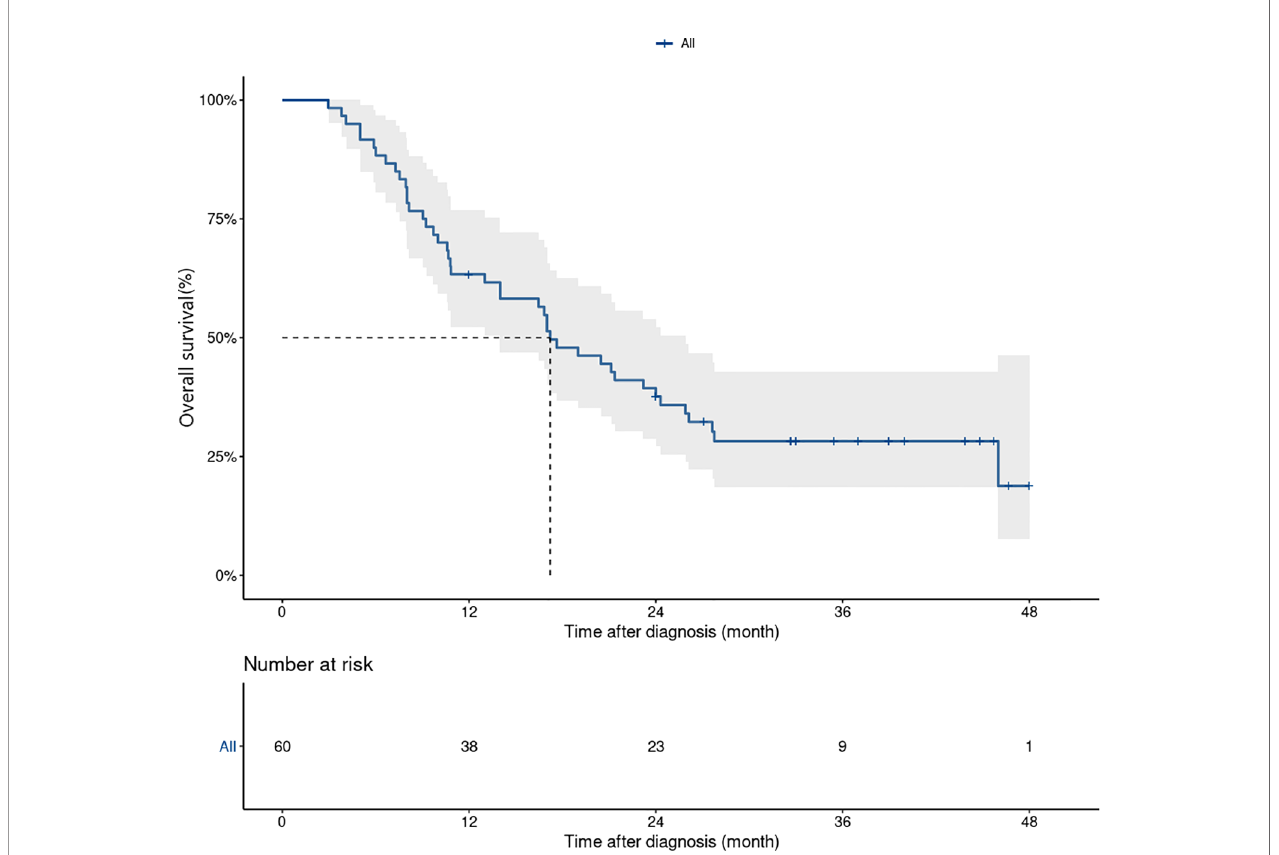
FIGURE 2 | Kaplan – Meier curves for overall survival in patients treated with dabrafenib and trametinib (n=60). Median OS and 3 years OS rate were 17.6 (95% CI, 13.1 – 22.1) month and 28.8% (95% CI, 19.1-43.6%),